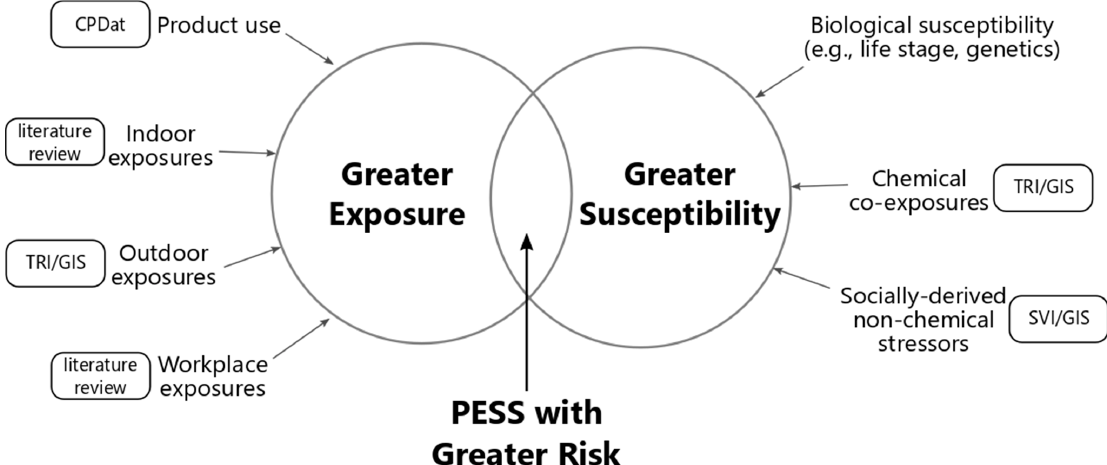
Figure 1. Conceptual framework for identifying potentially exposed and susceptible subpopulations to individual chemicals under the Toxic Substances Control Act. Rounded rectangles represent data sources/approaches used in this evaluation. Figure acronyms: USEPA Chemical and Products Database (CPDat), USEPA Toxics Release Inventory (TRI), geographic information system (GIS), Centers for Disease Control and Prevention Social Vulnerability Index (SVI).